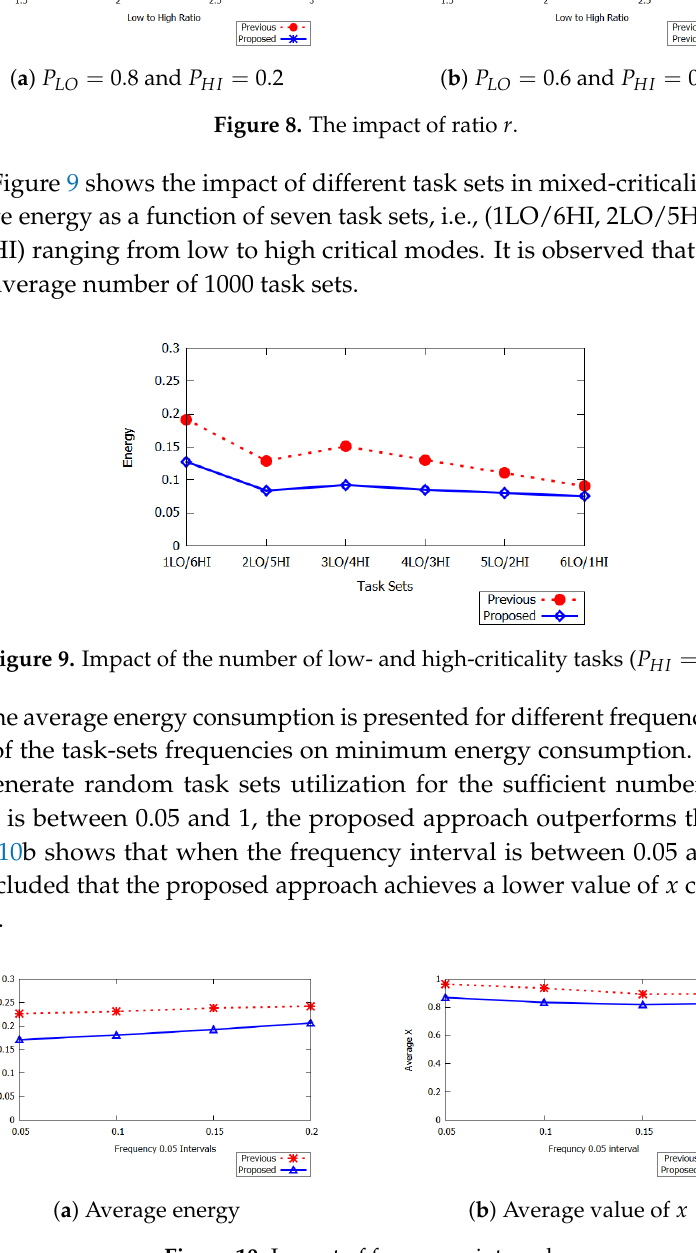
Figure 10. Impact of frequency